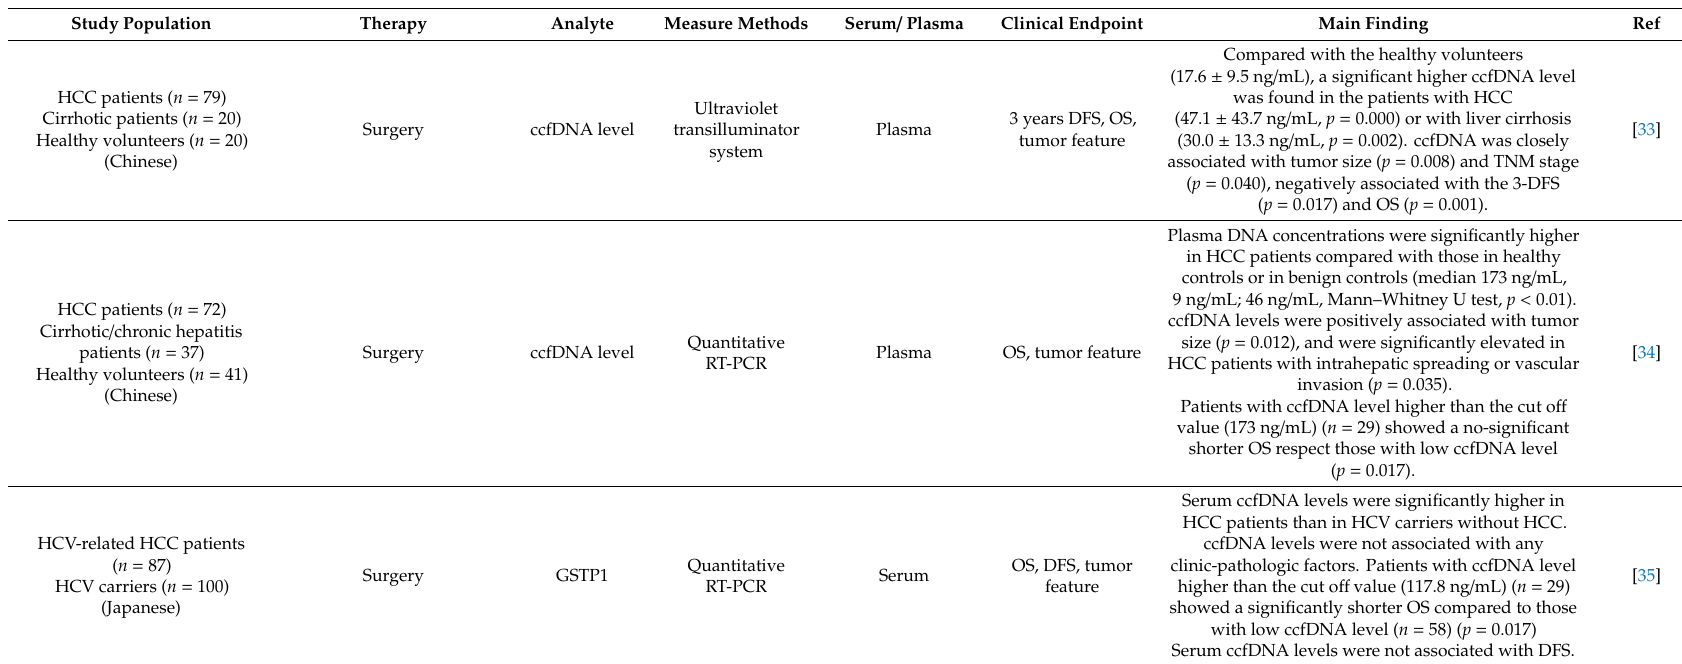
Table 1. Level of circulating cell-free DNA (ccfDNA) and therapy outcome in hepatocellular carcinoma (HCC)